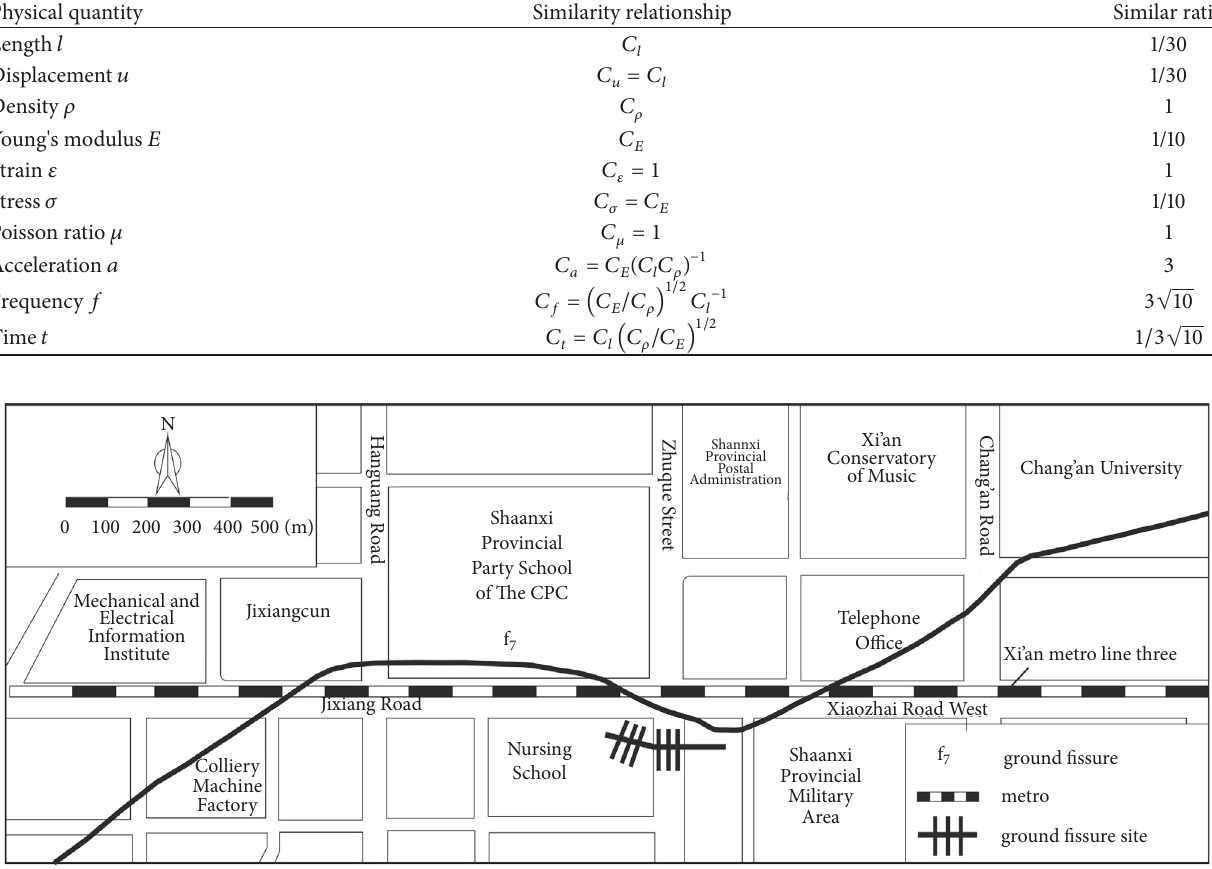
Figure 1: Map of Xi’an metro 3rd line and fissure f 7 on Jixiangcun-Xiaozhai